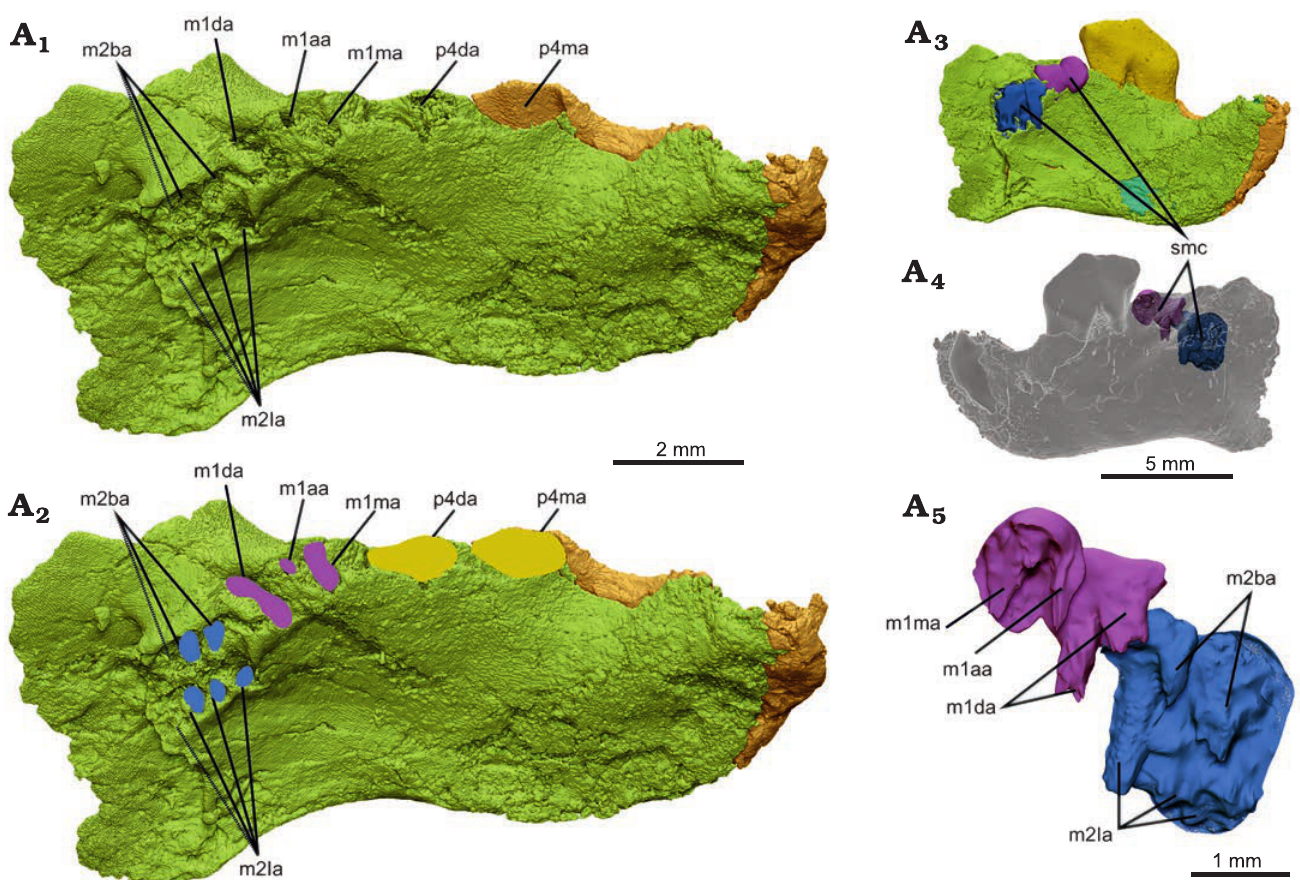
Fig 6. Interpretation of molar alveolar structure in dentary, NMV P252730, of the cimolodontan multituberculate Corriebaatar marywaltersae Rich, Vickers-Rich, Flannery, Kear, Cantrill, Komarower, Kool, Pickering, Trusler, Morton, van Klaveren, and Fitzgerald, 2009, Flat Rocks locality, Eumeralla Formation, Barremian, Lower Cretaceous of Victoria, Australia. Partial left dentary in dorsomedial view with p4 digitally extracted (A 1 ), outlines of interpreted alveoli for p4 (yellow), m1 (purple), and m2 (blue) (A 2 ). Medial (A 3 ) and lateral (A 4 ) views of dentary with computer-simulated mold-mak- ing compound overlying the partially preserved alveoli of m1 and m2 and filling the voids. A 3 and A 4 are views of entire specimen to provide context, dentary semi-transparent in A 4 . Simulated mold-making compound enlarged (A 5 ) showing the parts that filled the voids of the partially preserved